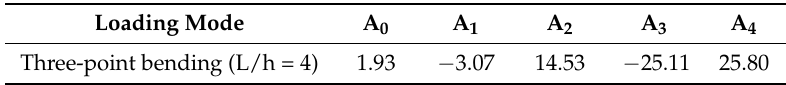
Table 1. Value of A 0 , A 1 , A 2 , A 3 and A 4